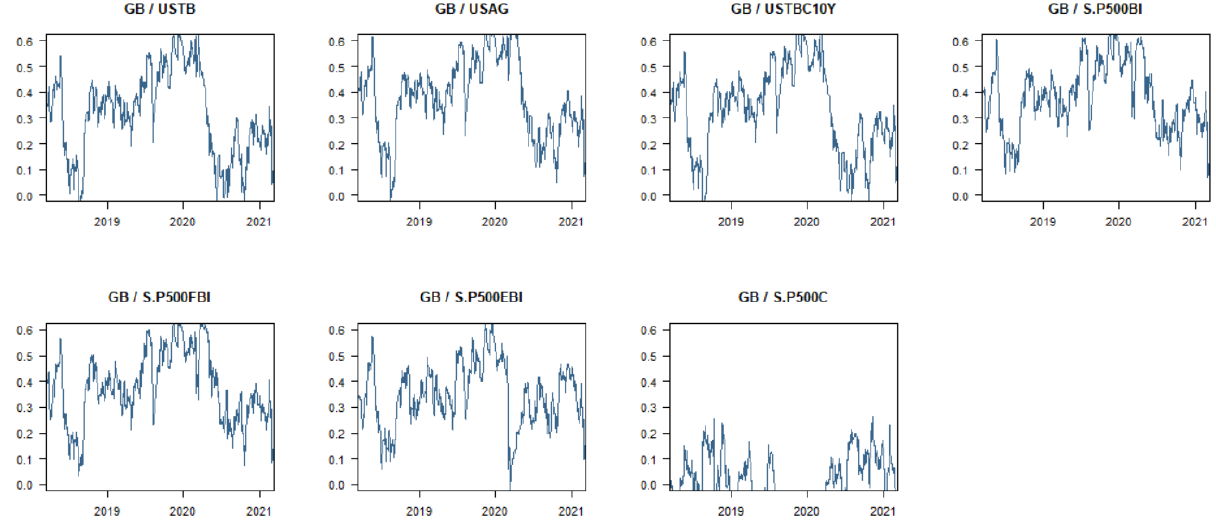
Figure 14. Dynamic hedge ratios (long/short).